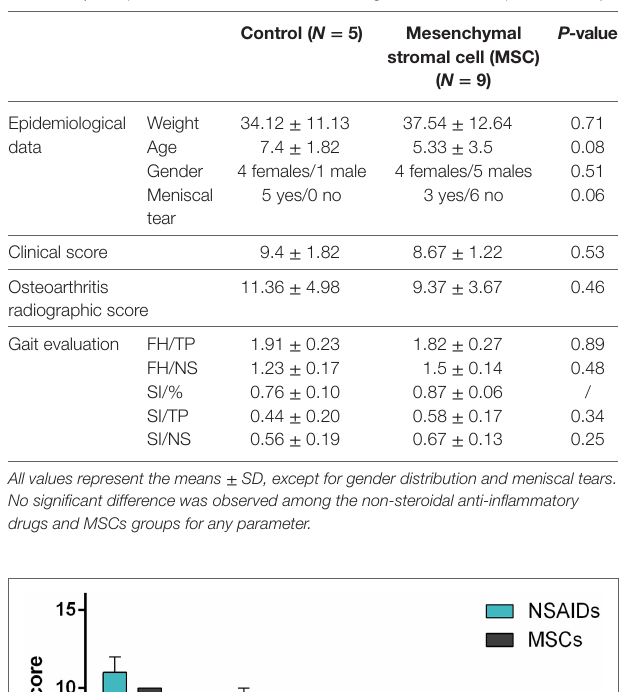
TaBlE 4 | Preoperative characteristics of the dogs enrolled in the present